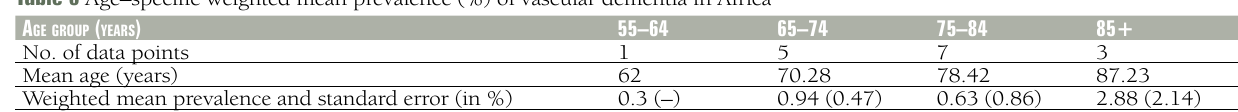
Table 6 Age–specific weighted mean prevalence (%) of vascular dementia in